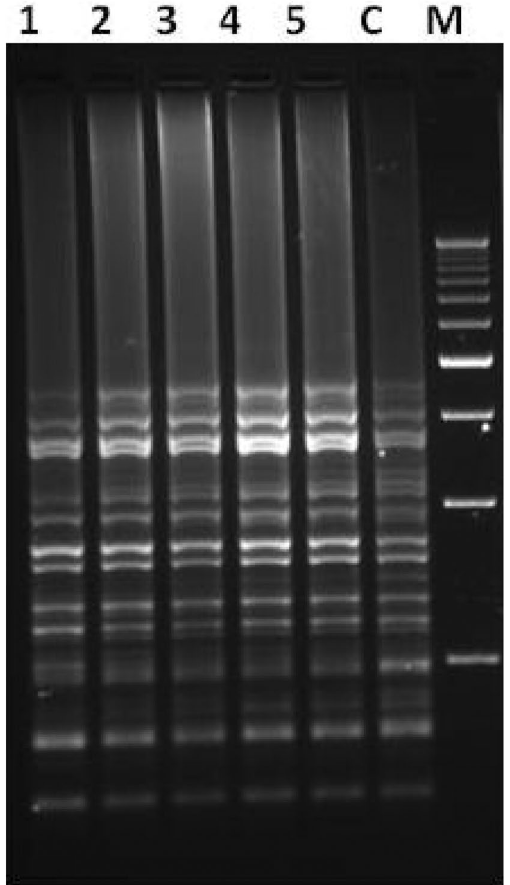
Figure 6. ISSR amplification pattern of plantlets grown in semisolid medium (Lane 1 and 2) and TIB (Lane 3–5) generated using primer (Lane C: Field grown control sample; Lane M: 500 bp Ladder). Leaves sample (randomly chosen 10 different plants pooled as one sample) collected performed the experiment with total of 50